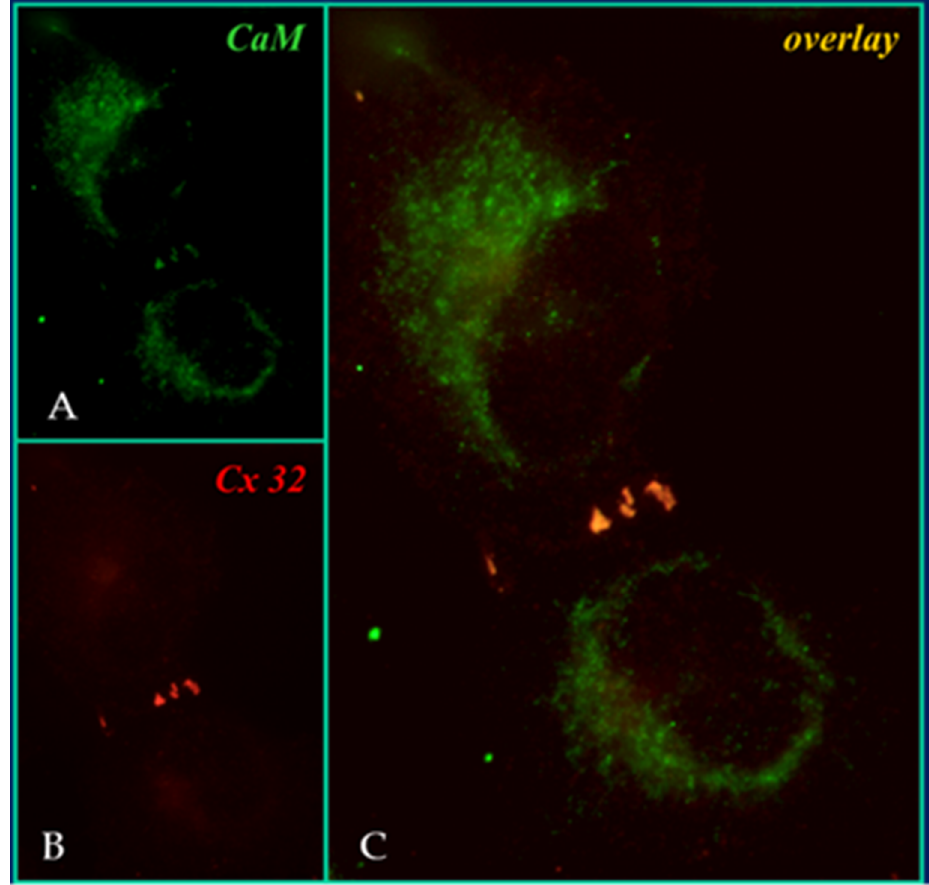
Figure 4. Immuno-fluorescence labeling of CaM ( A ) and Cx32 ( B ) in HeLa cells. The overlay of ( A , B ) is shown in ( C ). Cx32 and CaM colocalize at three punctuated areas of cell–cell contact. From Ref.